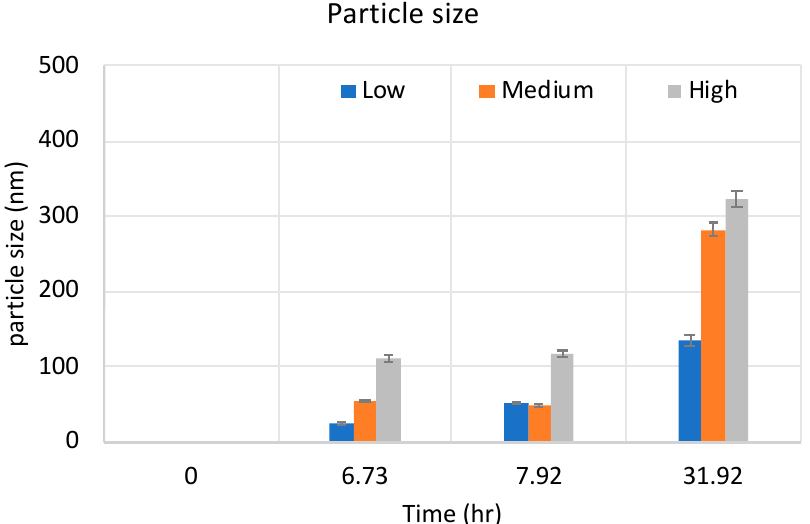
Figure 6. Measurement of particle size of as-spun fiber and after calcination. direction divided by the size in the radial direction, for all calcined samples were almost always equal to one (except in high-concentration sample soaked for 24 h), indicating that the growth rate of the particles in the radial and longitudinal direction was similar (Figure 7).